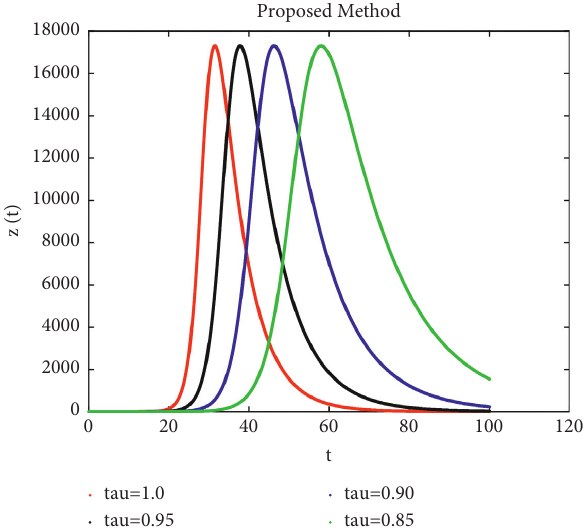
Figure 18: Dynamical behavior of free HIV virus particles at α � 1 and various fractal order � 0.85, 0.9, 0.95, 1 under Mittag-Leffler kernel.